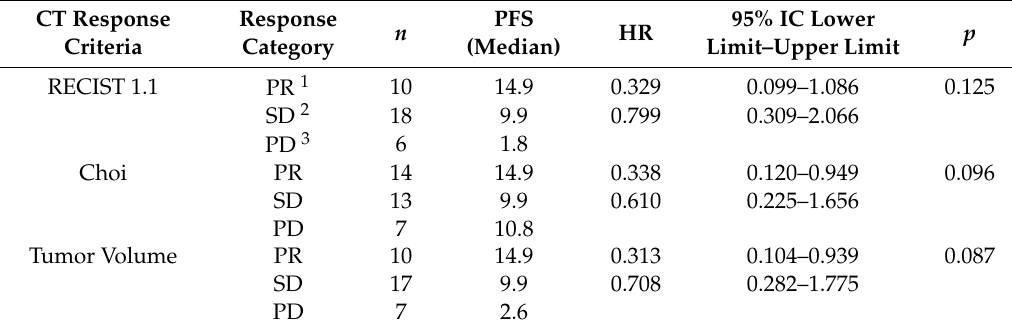
Table 2. Progression free survival (PFS) univariate analysis according to RECIST 1.1, Choi and volume staging criteria.